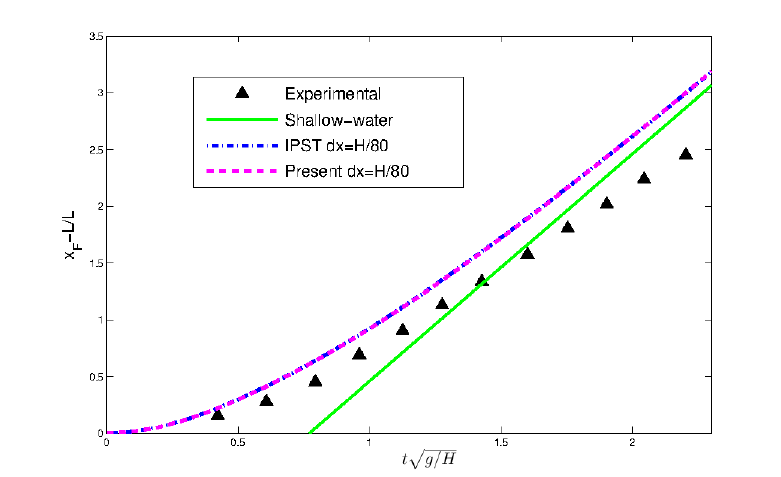
Figure 24. Dam break flow: time evolution of the water front, the green solid line presents the analytical solution from shallow water theory [76], The black triangles denotes the experimental data given by Buchner [69]. The blue dash-dot line represents the results obtained by using IPST [37], whereas for the magenta dashed line presents the results obtained by the present particle shifting formulation.